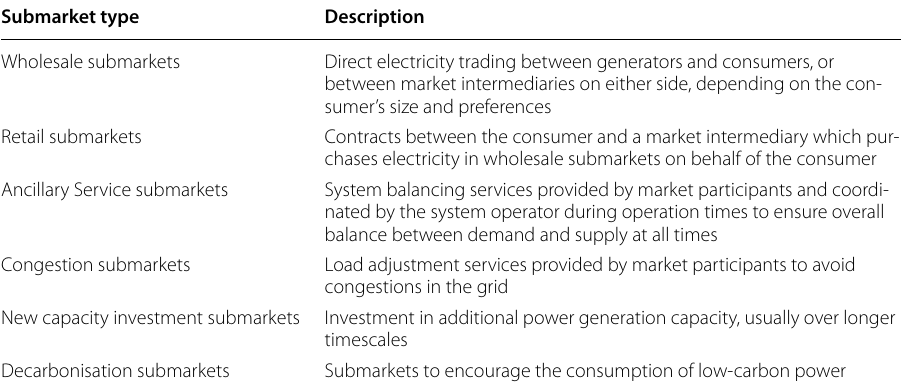
Table 1 Submarket types found in liberalised electricity market